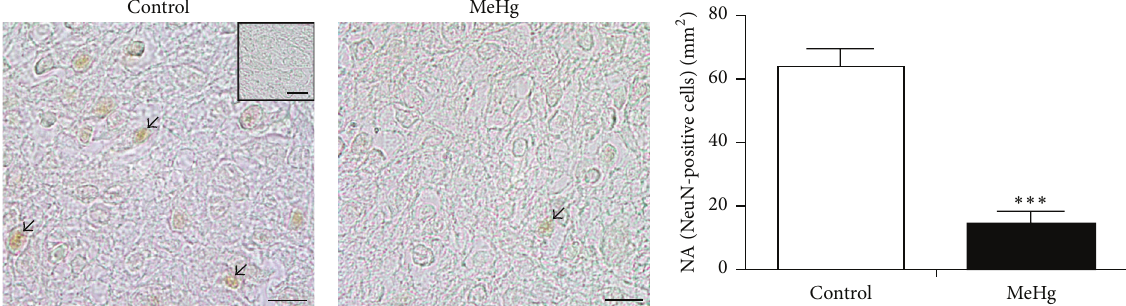
Figure 8: NeuN, a neuron-specific nuclear protein, analyzed by immunohistochemistry. Positive cells (arrows) were found in the mantle layer. The square in the control image represents the negative control of immunohistochemical reaction. The graph displays the NA of NeuN- positive cells. Bars are represented as mean ± SEM. ∗∗∗ 𝑃 < 0.0001 . Scale bars: 10 𝜇